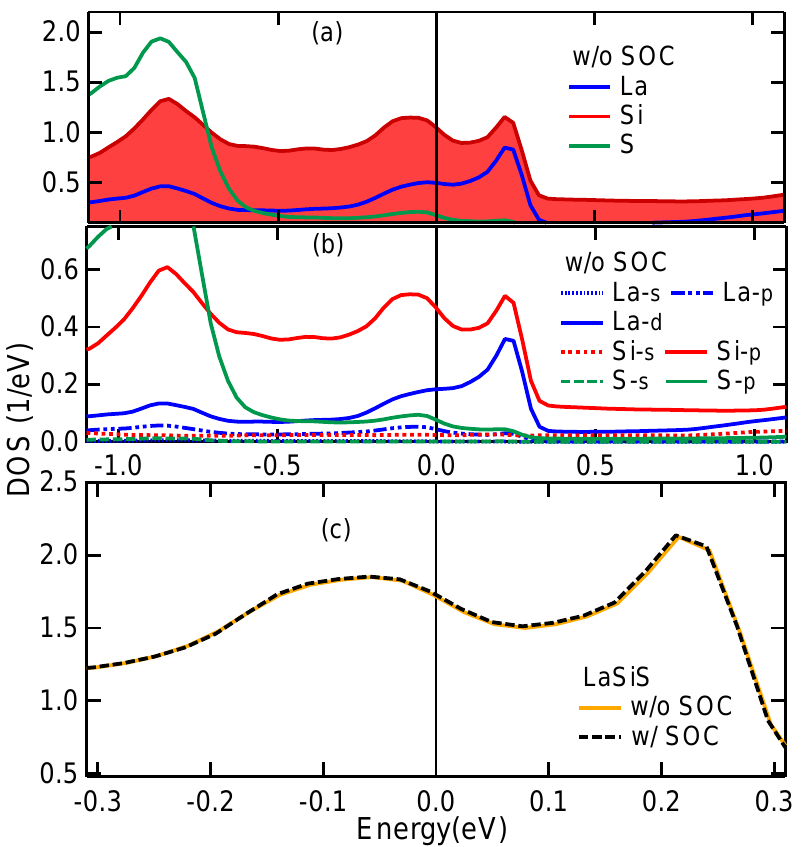
Figure 3. (Color online) Calculated atom-projected DOS for LaSiS without SOC and total DOS with and without SOC effect. Panel ( a ): Calculated DOS without SOC for La, Si, and S represented in blue, red and green, respectively. Panel ( b ): Calculated DOS for La( s , p and d ), Si( s and p ), and S( s and p ) orbitals without SOC. Panel ( c ): Calculated total DOS for LaSiS with (black) and without (orange) SOC. The solid black vertical line at zero indicates the Fermi